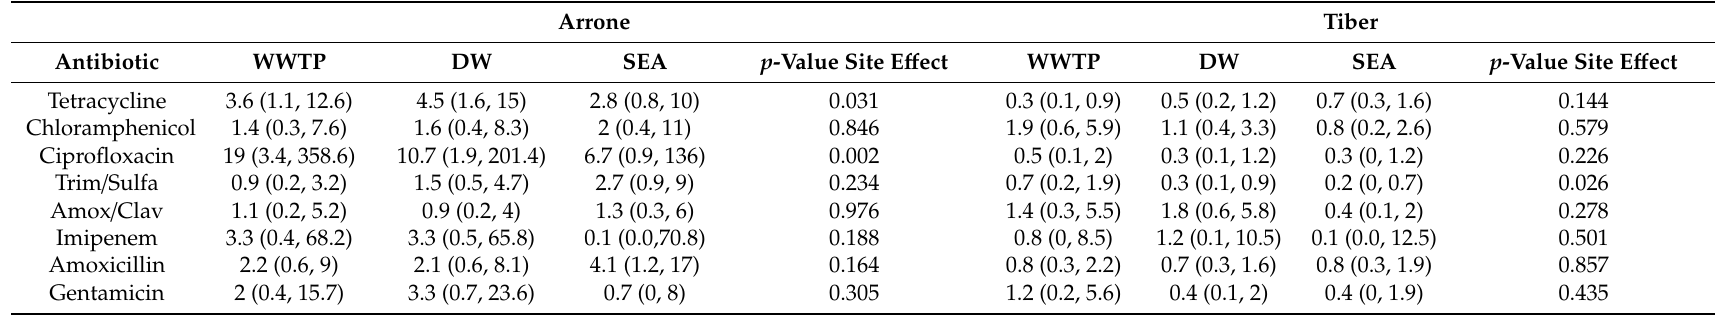
Table 2. Di ff erences in the frequency of antibiotic resistance pattern of E. coli isolates between sites after controlling for sampling date. Reported values are odds ratio (OR) and lower and upper bounds of 95% confidence intervals calculated with logistic regression using the upstream site (UP) as reference. The p -value of the site e ff ect was calculated with the likelihood ratio test between models with and without the site term. The analysis for cefotaxime was not carried out because of complete separation in some of the samples. Significant p -values are indicated in bold type. Trim / Sulfa: Trimethoprim + Sulfamethoxazole, Amox / Clav: Amoxicillin